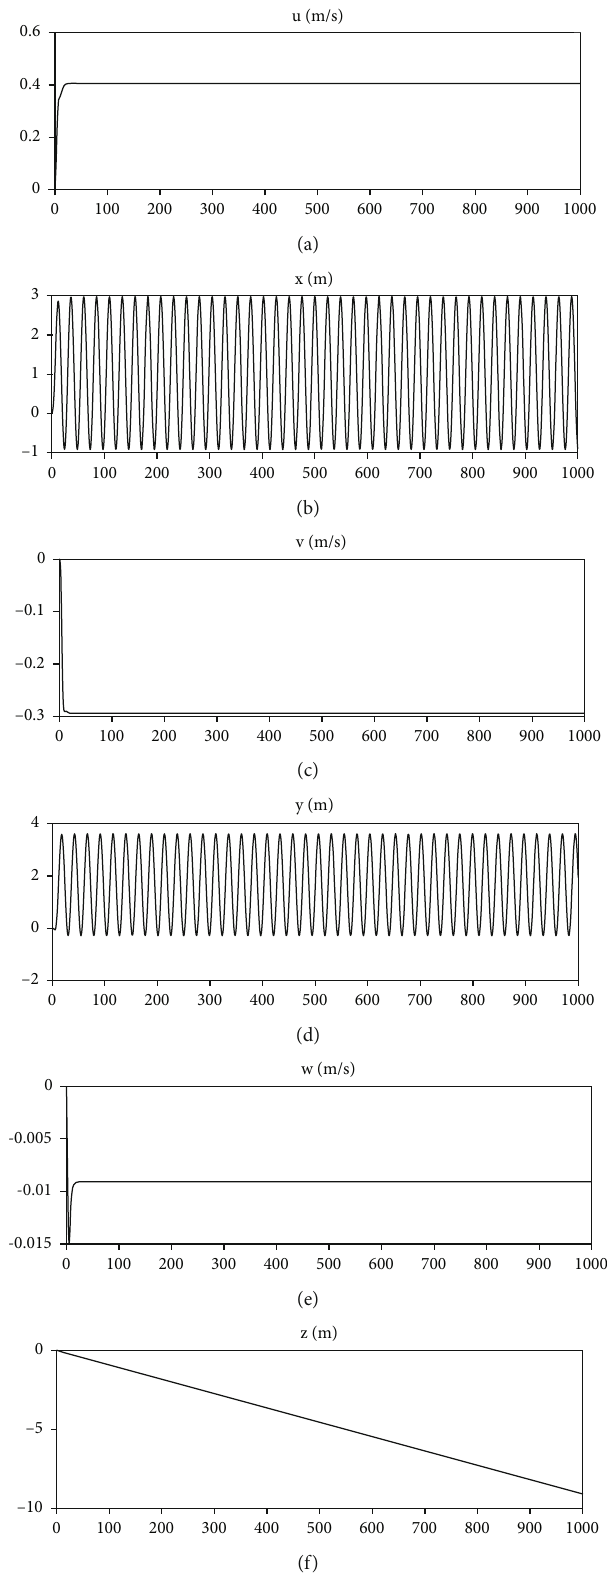
Figure 13: Relationship between velocity, displacement, and motion simulation time: (a) velocity u ; (b) velocity v ; (c) velocity w ; (d) displacement x ; (e) displacement y ; (f) displacement z